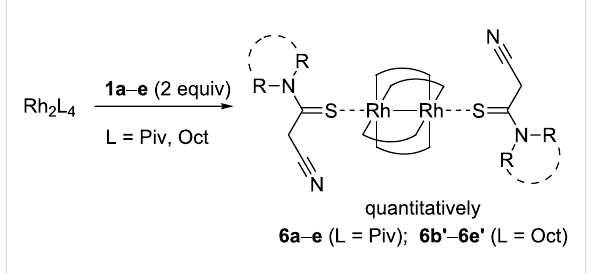
seen as the singlets at the range of 6.40–6.78 and 96.8–92.8 ppm,